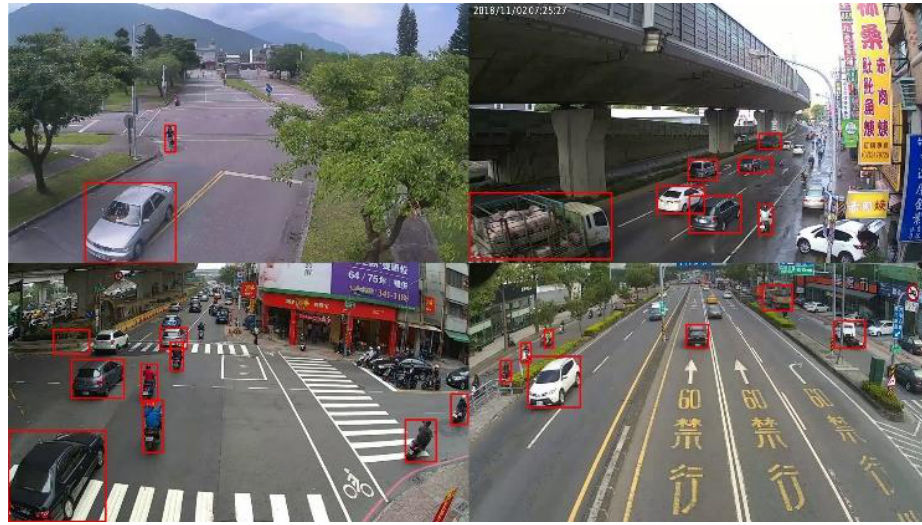
Figure 14. Sample images from our self-collected dataset.